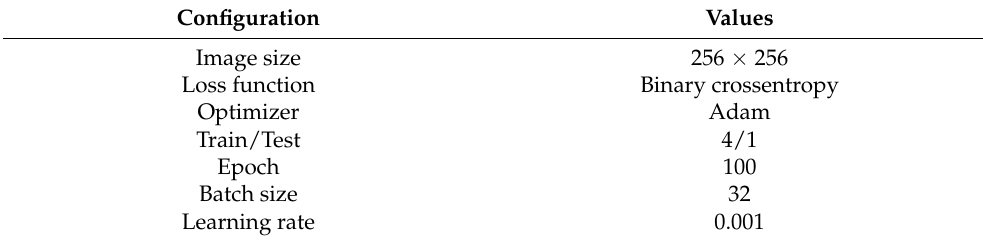
Table 2. Comparison of different algorithms (%).